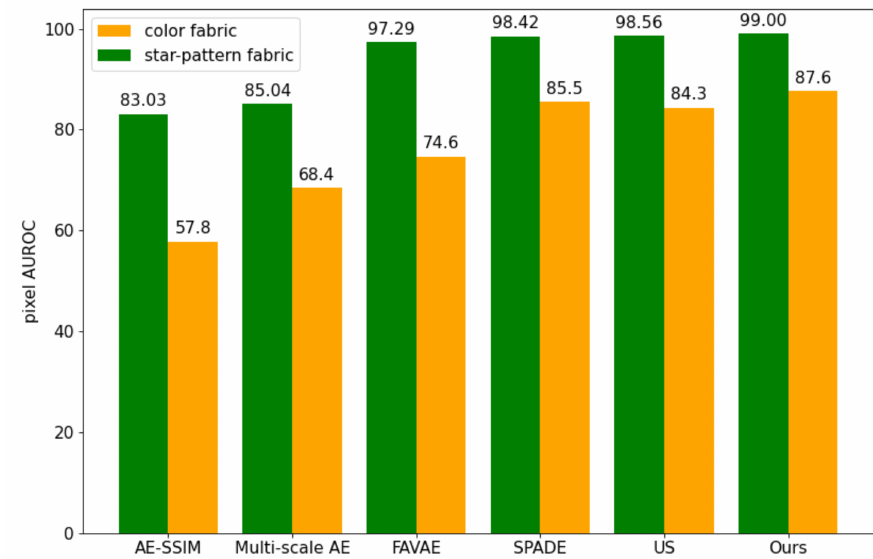
Figure 8. The comparison of different methods used on the two